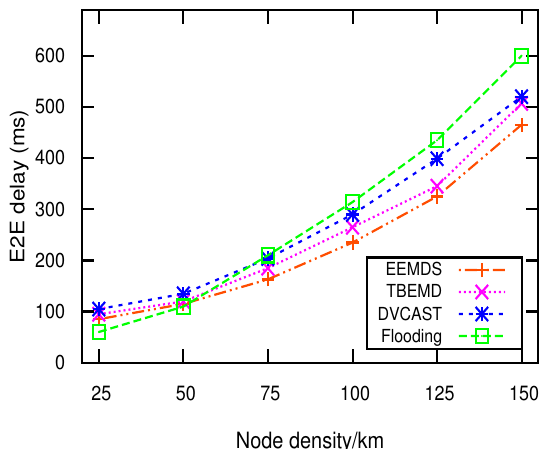
Figure 4. E2E delay vs. node